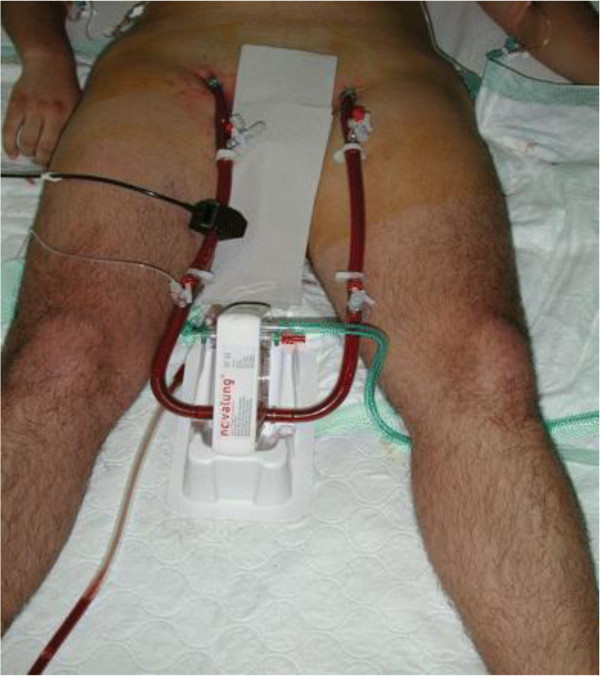
Interventional lung assist device (iLA™; NovaLung GmbH, Talheim, Germany) for pumpless arterio-venous carbon dioxide removal. Reproduced with permission from [27].